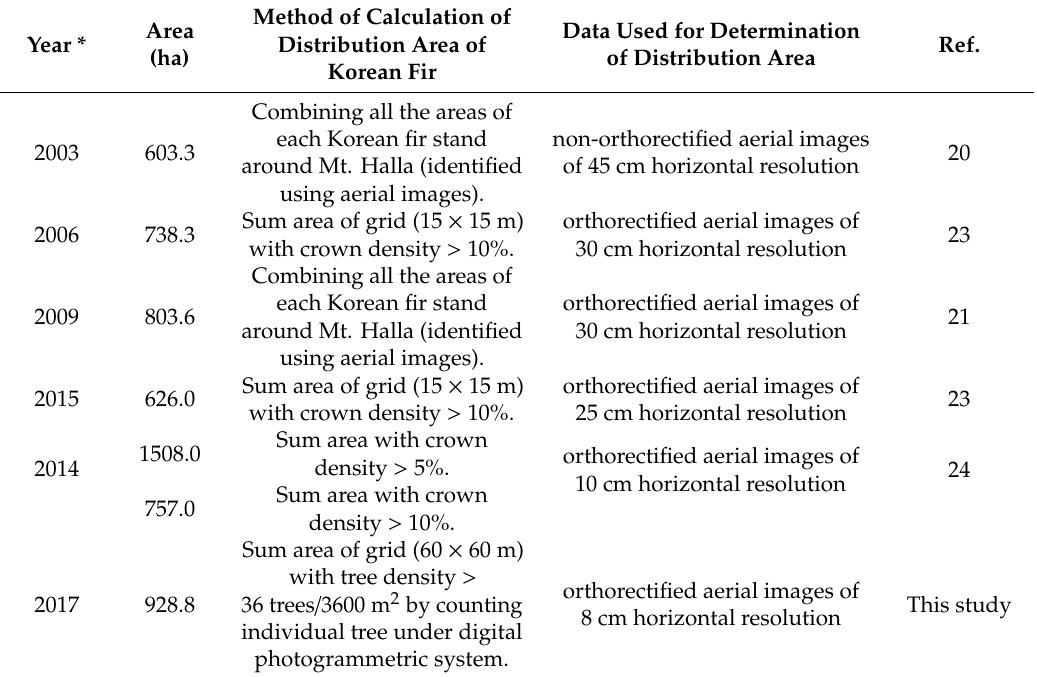
Table 10. Previous studies on the distribution of the Korean fir on Mt. Halla.